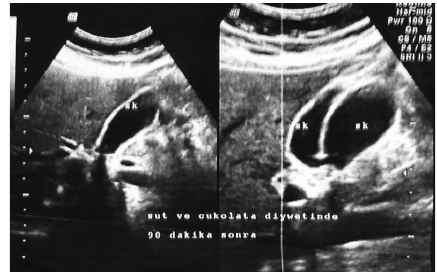
Figure 1: Ultrasound image of both gallbladders.